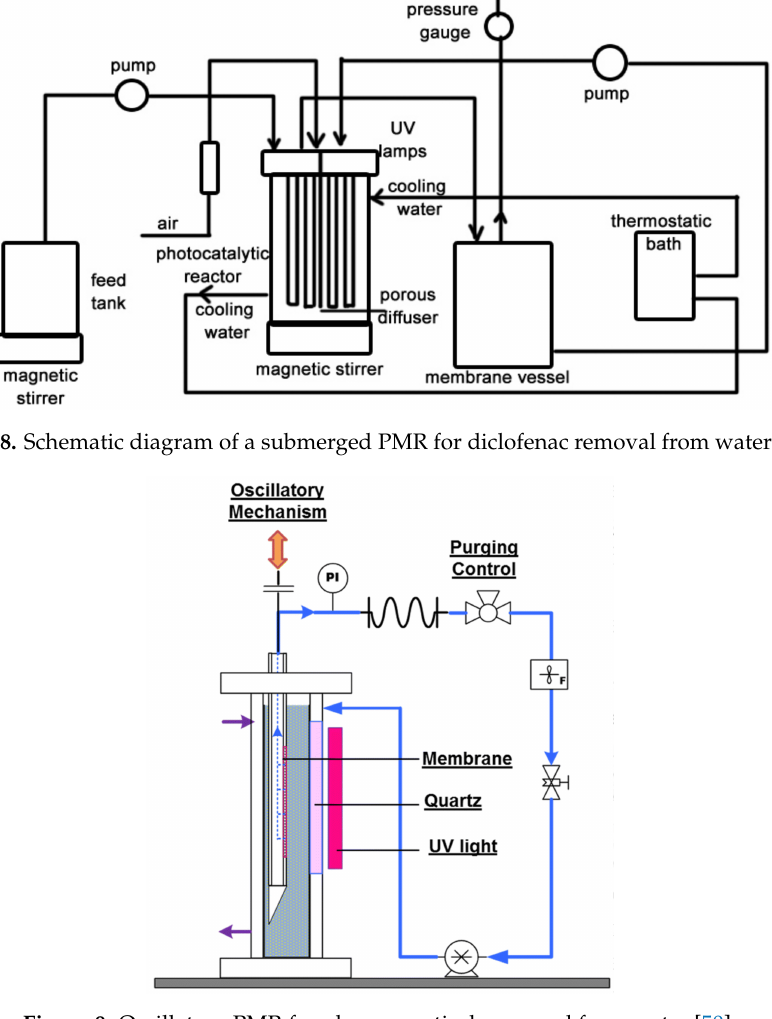
Figure 9. Oscillatory PMR for pharmaceuticals removal from water